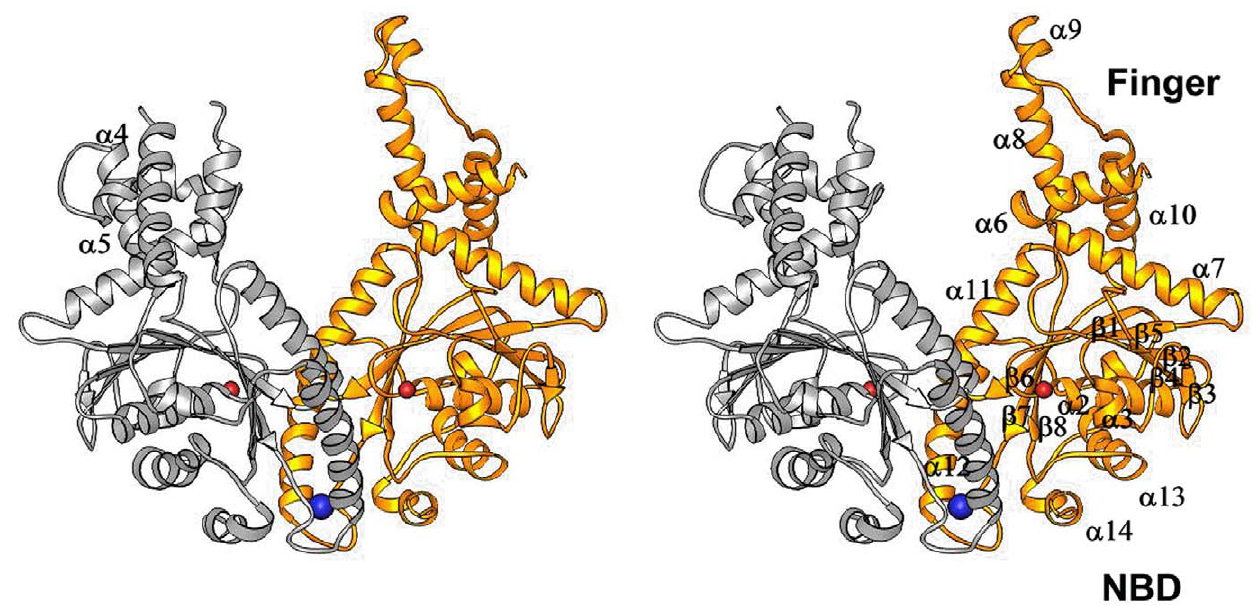
Figure 1. Ribbons drawing of the S.cerevisia Get3 homo-dimer structure in side-by-side stereo mode. The monomer A is in silver and the monomer B is in gold. The a -helices and b -strands are labeled in the structure. The nucleotide-binding domain (NBD) and the finger domain (Finger) are labeled. The Zinc ion is shown in a blue sphere and the two Mg ions at the nucleotide-binding sites are shown in red spheres. The missing parts of the structure are linked by dotted